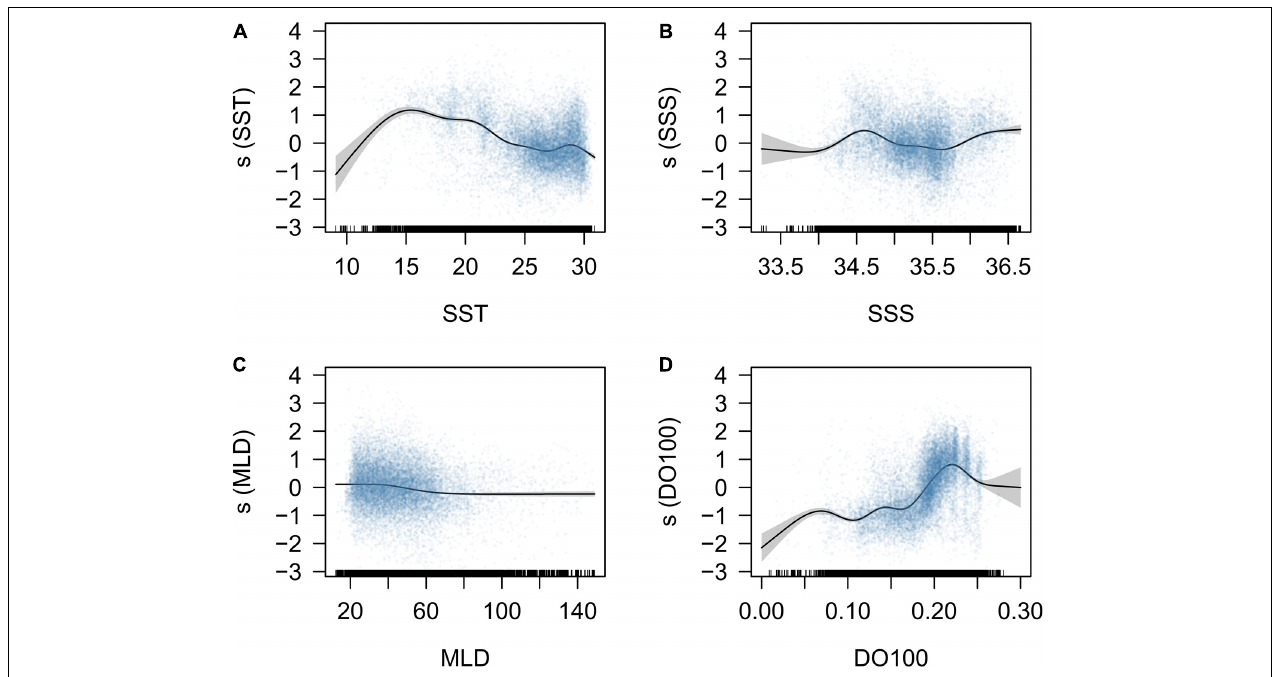
FIGURE 1 | Response curves for the environmental variables, including the (A) sea surface temperature (SST, ◦ C); (B) sea surface salinity (SSS, PSU); (C) mixed layer depth (MLD, m), and (D) dissolved oxygen concentration under 100 m depth (DO100, mmol L − 1 ), derived from the GAM model. The blue points represent the partial residuals of observed CPUE data, and the gray polygons represent the 95% confidence interval. The hatch marks at the bottom are a descriptor of the frequency of data points.